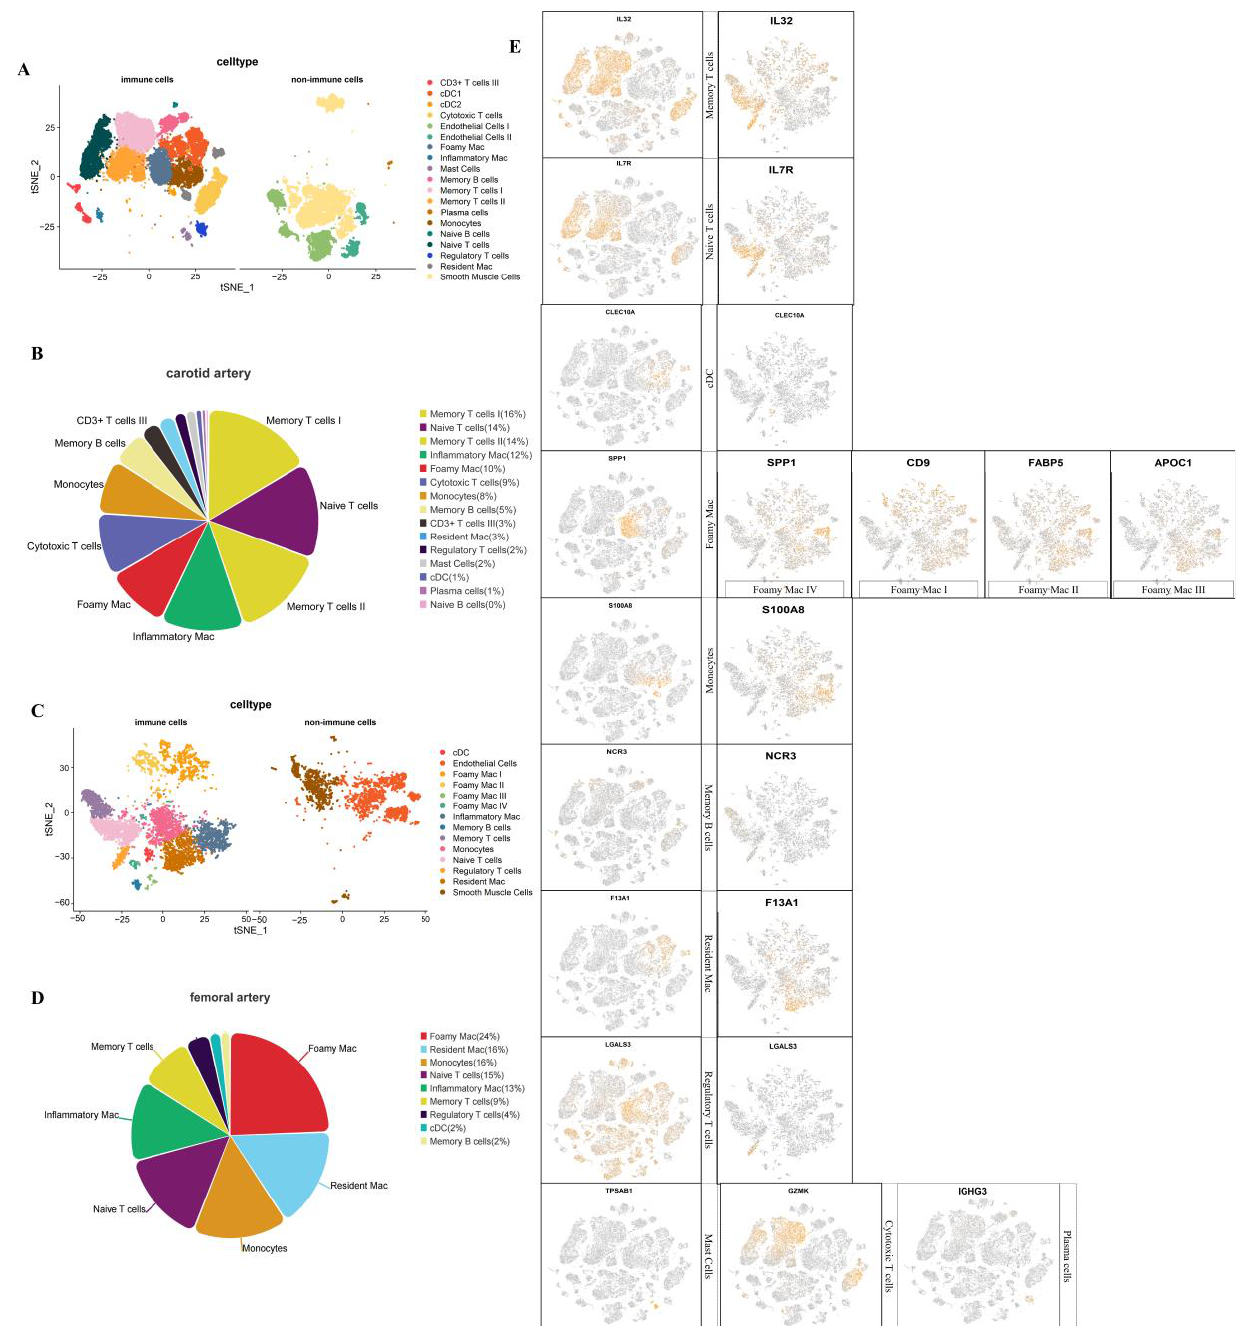
Figure 3. ( A , C ) are cluster plots of immune cells isolated from carotid and femoral atherosclerotic plaques, respectively. ( B , D ) are the proportions of each immune cell in the carotid and femoral arteries, respectively. In the two plots, yellow is for memory T cells, purple for natural T cells, green for inflammatory macrophages, red for foam cells, cyan gray for killer T cells, orange for monocytes, light yellow for memory B cells, black for CD3 T cells, sky blue for resident macrophages, dark purple for regulatory T cells, gray for mast cells, cyan represents cDC cells, burgundy represents plasma cells, and pink represents natural B cells. The genes used by the two plaques to identify cell types are the same. ( E ) shows the marker gene of each cell type and the distribution of this marker gene in the cluster map. Among them, cytotoxic T cells, mast cells, and plasma cells were only found in carotid plaques, which we marked at the end of the picture. There are four types of foam cells in the femoral